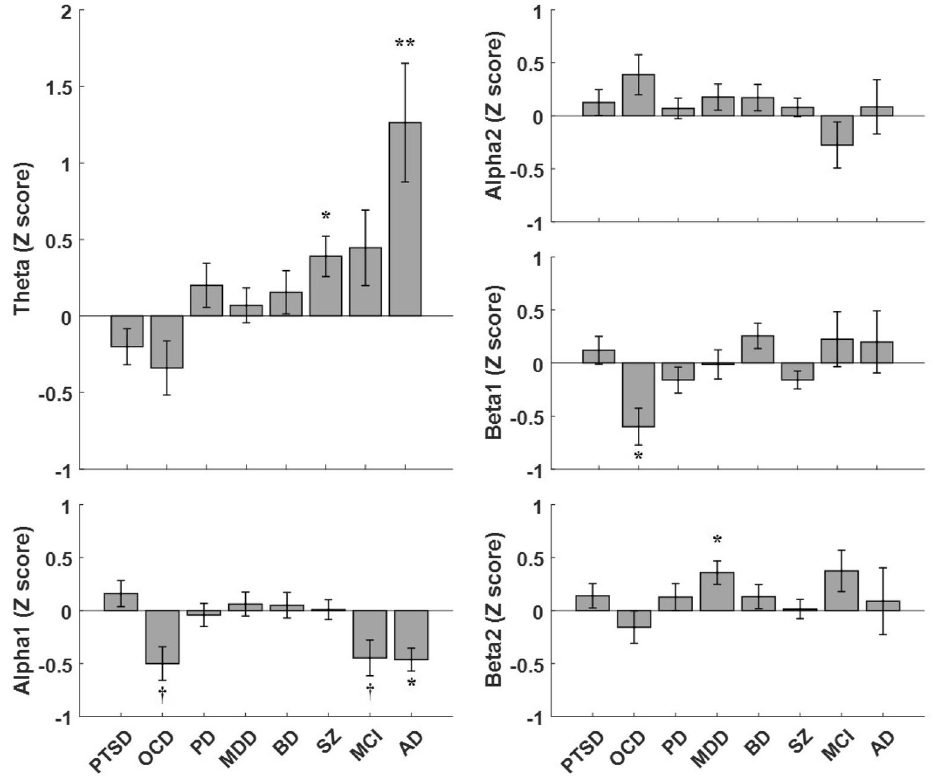
Figure 3. The global CC indices for various frequency bands. The global CC values of each group were normalized to those of the corresponding HC group, using z-transformation. Each bar indicates the averaged z-score of the global CC value of the disorder group. The error-bars indicate standard error. † p < 0.07, *p < 0.05, **p < 0. ( PTSD posttraumatic stress disorder, OCD obsessive compulsive disorder, PD panic disorder, MDD major depressive disorder, BD bipolar disorder, SZ schizophrenia, MCI mild cognitive impairment, AD Alzheimer’s